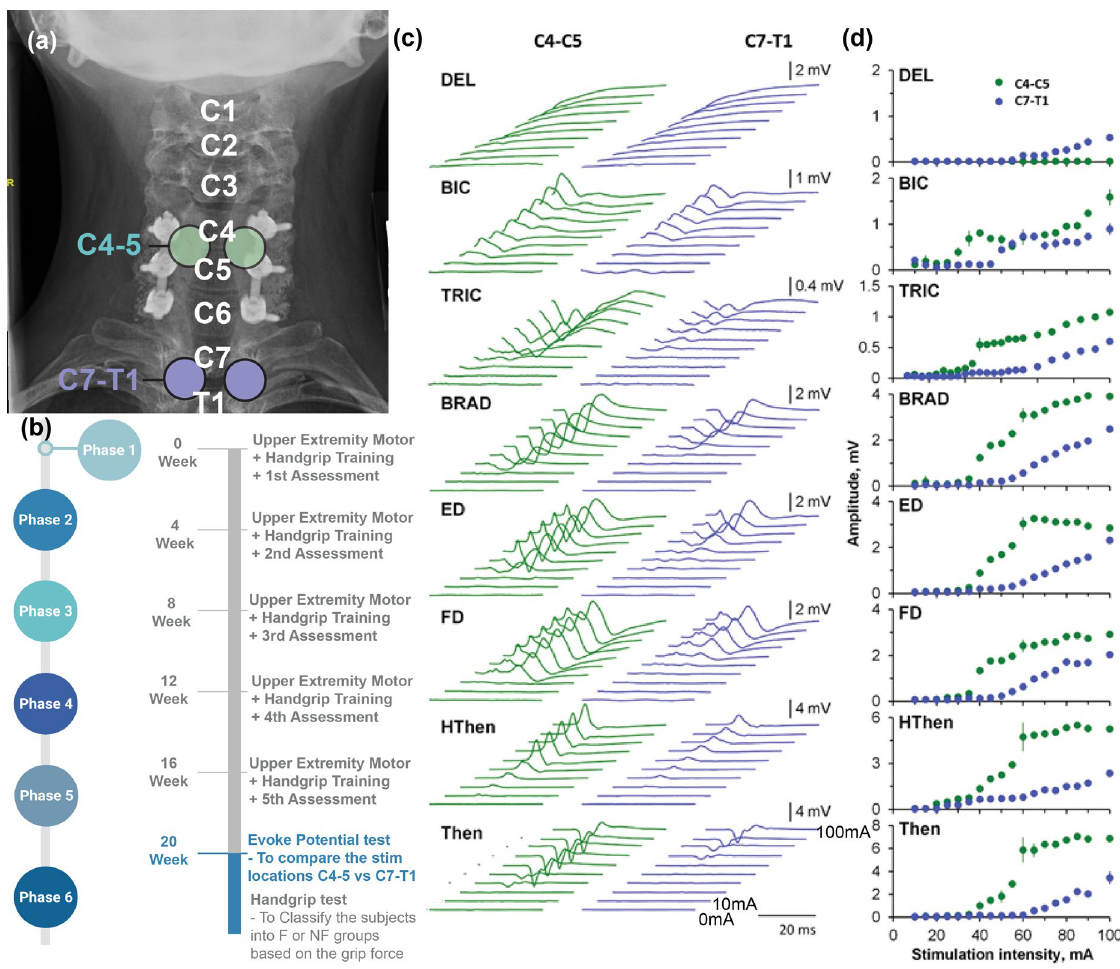
Figure 2. The procedure of determining the stimulation location was based on evoked potential testing. The evoked potential stimulation with 1 Hz was performed after all the hand function training to select the optimal stimulation intensity for each individual subject. ( a ) Two candidate stimulation locations, C4-C5 (Cyan) and C7-T1 (Blue), were tested. ( b ) The evoked potential test was performed during the last week of the 20-week Phase 1 period. ( c ) Representative evoked responses from one participant (S2, AISA A, C4) during tSCS at C4 and C7. The time windows between 5 and 45 ms following the stimulus are shown. ( d ) The recruitment curves of the right arm muscles of S2 at each location of spinal stimulation are shown. DEL, deltoid; BIC, biceps brachii, TRIC, triceps brachii; BRAD, brachioradialis; ED, extensor digitorum; FD, flexor digitorum; HThen, hypothenar; Then, thenar muscles. ( a ) is licensed under Shutterstock (Stock photography assessed the overall disability, motor lesion grade, precise hand function, and spasticity of each subject at base- line and following each treatment phase using standardized tests. To assess overall disability, we used the Ameri- can Spinal Cord Injury Association (ASIA) Impairment Scale (AIS, Table 1) and the International Standards for Neurological Classification of Spinal Cord Injury (ISNCSCI measurement; Fig. 7). Precise assessment of hand function was performed with the Graded Redefined Assessment of Strength, Sensibility, and Prehension (GRASSP 1.0) 17,18 . The Spinal Cord Independence Measure (SCIM) 19 and the Capabilities of Upper Extremity Questionnaire (CUE-Q) were used to confirm each patient’s level of function 2 . Spasticity of all eight muscles was assessed using the Modified Ashworth Scale and the Penn Spasm Severity/ Frequency Scale 20–22 . We also adapted a Visual Analog Scale (VAS) to assess spasticity: 0 cm corresponded to no spasticity in the prior 24 h, whereas 10 cm corresponded to the worst possible spasticity. The distance measured was converted to a percentage of the total line length to account for discrepancies in total line lengths related to different magnifications generated by different printers 23 . Subjects completed the VAS assessment each day for 7 days prior to each of the four treat- ment phases as well as 7 days after the end of the last treatment phase (Both).